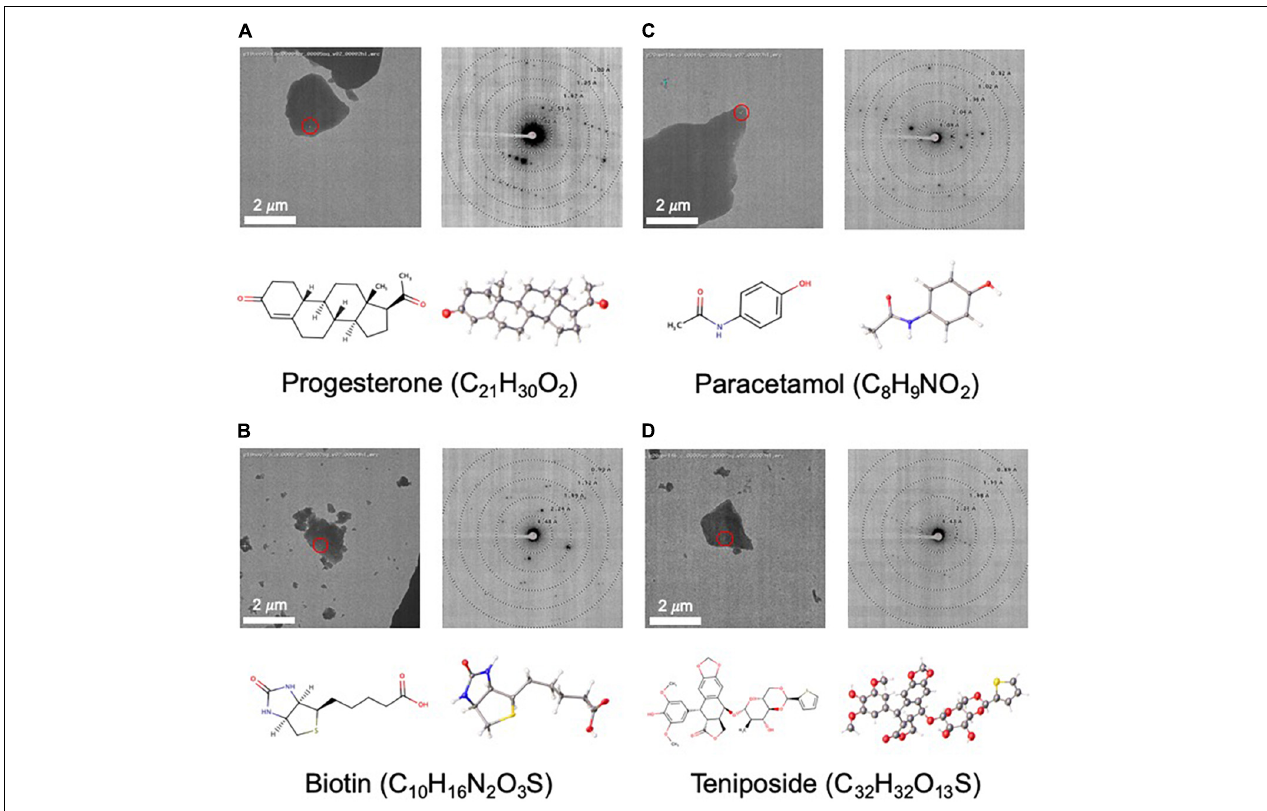
FIGURE 4 | Structures determined by NIS as internal controls (A–C) and as a proof of concept for a more challenging sample (D) . For each panel, an image of a targeted crystal is shown with the beam diameter shown as a red circle, along with an exemplary diffraction image with overlaid resolution rings. Below this, the 2D structure is shown alongside the MicroED structure with atoms displayed as thermal ellipsoids. Note that no distinction is made between single or double bonds in the thermal ellipsoid image. The common name and chemical formula are also